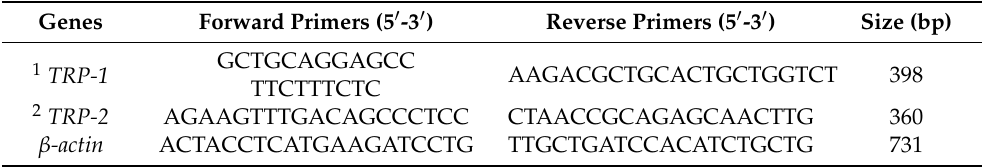
Table 1. List of primers used to determine gene expression of TRP-2 and TRP-1 using RT-PCR. The sequences of primers for each gene are shown as forward and